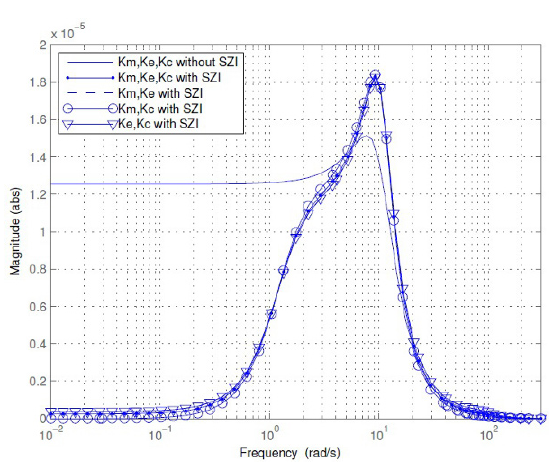
Figure 13. Frequency response between the and without SZI in the loop.